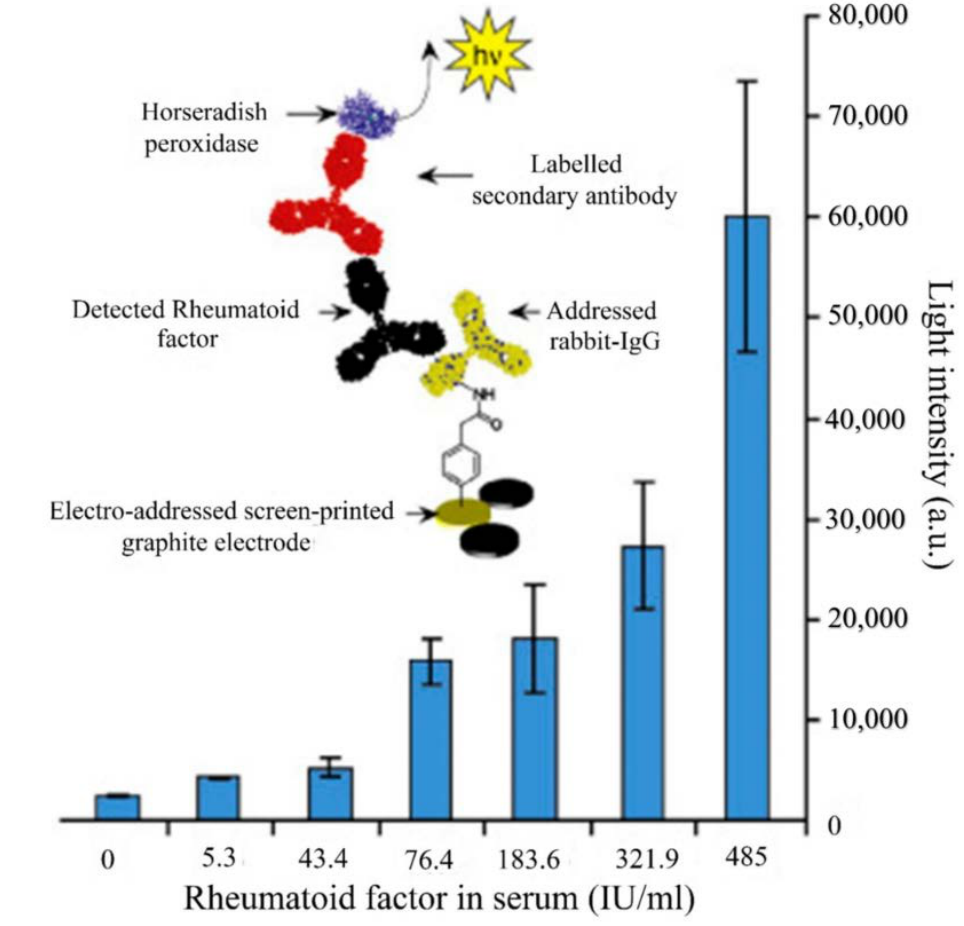
Figure 17. Schematic representation of the capture immunoassay performed on a screen-printed graphite electrode. Histogram: chemiluminescent detection of RF in human sera using screen-printed (SP) microarrays. Reprinted [168], Copyright 2007, with permission from Elsevier.